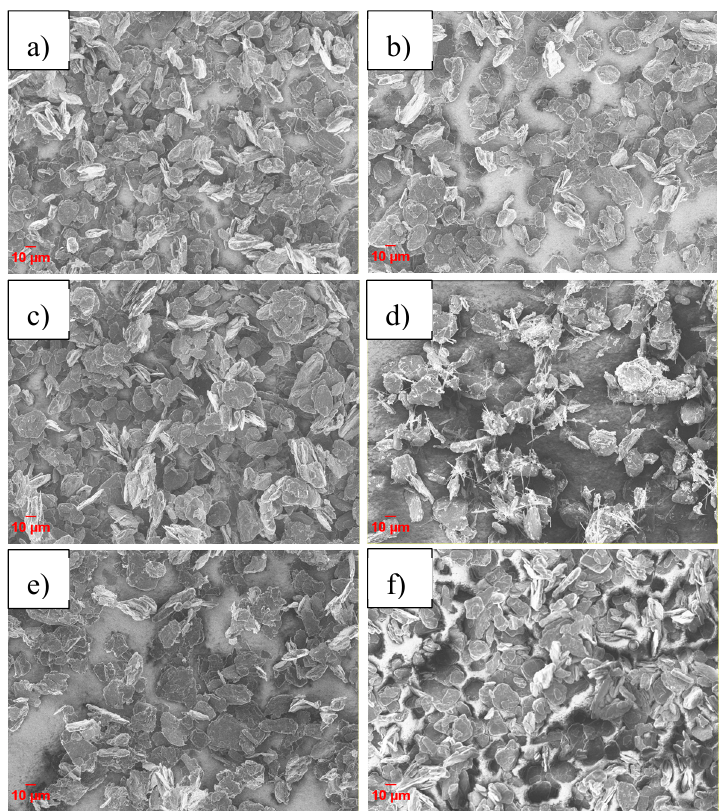
Figure 3. Scanning electron microscopy (SEM) images of carbon-coated materials: ( a ) Gr/Sucrose; ( b ) Gr/Glucose; ( c ) Gr/CA; ( d ) Gr/PAA; ( e ) Gr/PVA; pristine graphite ( f ) is also shown for comparison.